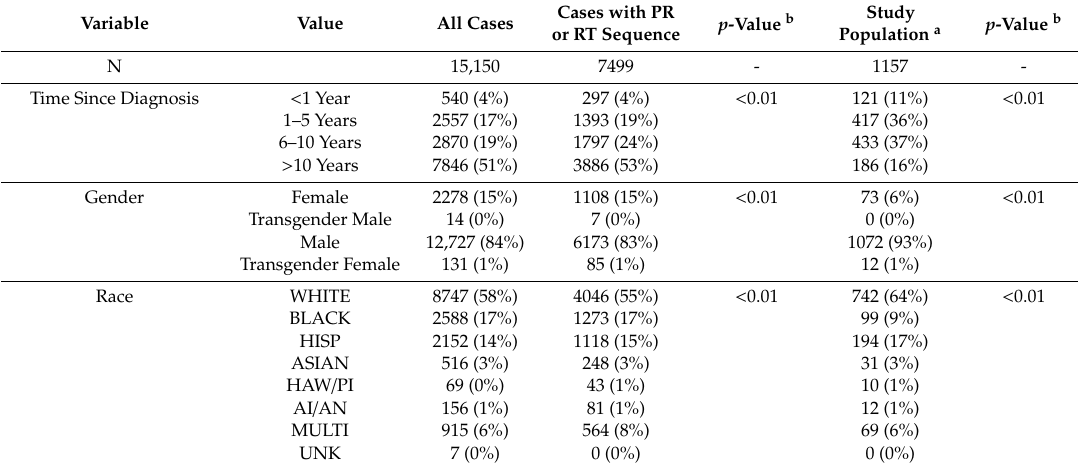
Table 3. Demographic characteristics of study population, prevalent cases, and cases with